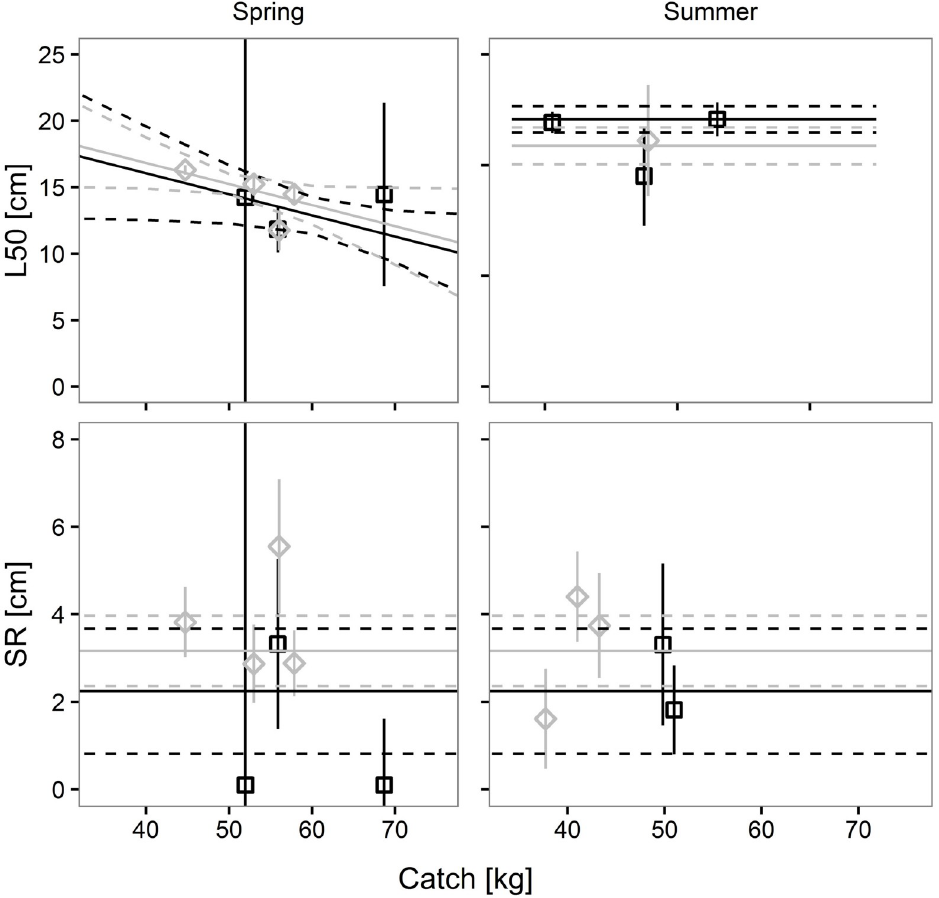
Fig 2. Prediction of Atlantic horse mackerel size selection parameters, L50 and SR, versus codend catch weight. Black solid and dashed lines represent the predicted mean values and 95% CI for the SM40 codend. Grey solid and dashed lines represent the predicted mean values and 95% CI for the DM50 codend. Squares and diamonds represent the results of each haul and their 95% CI for the SM40 and the DM50 codend, respectively.